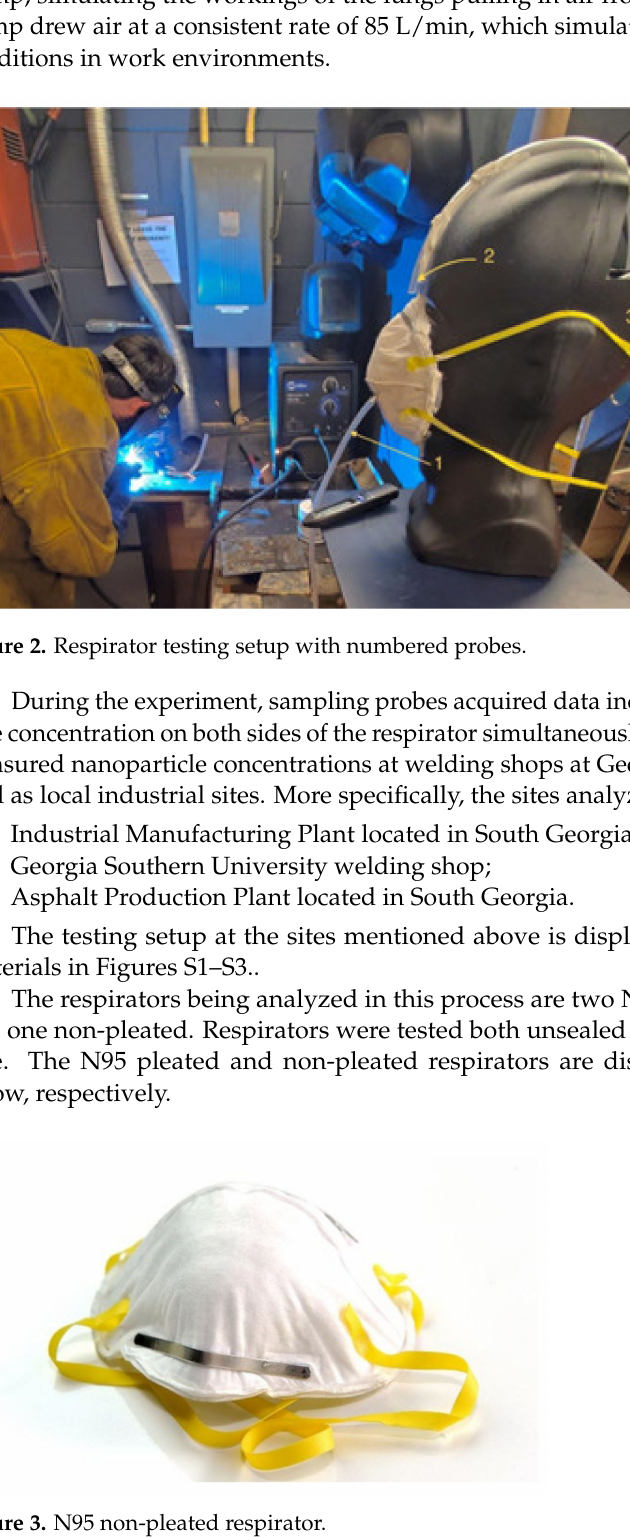
Figure 3. N95 non-pleated